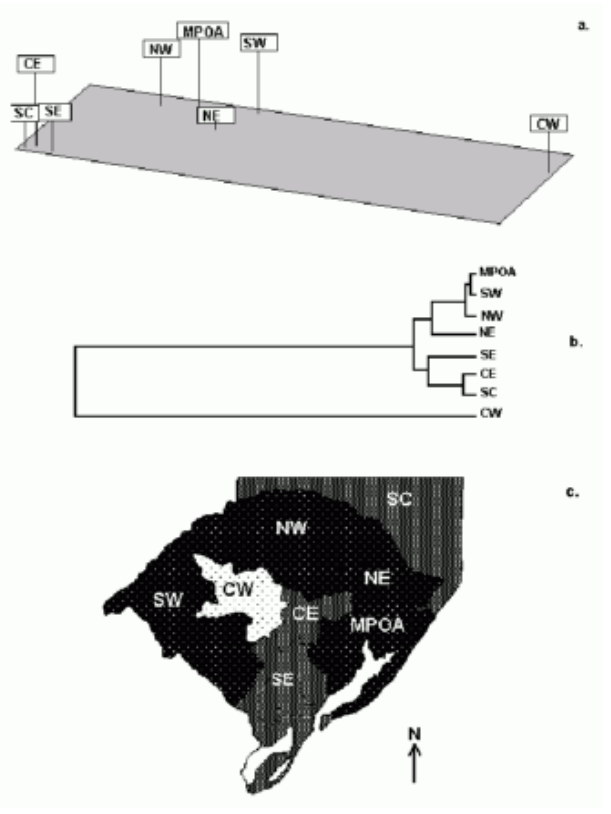
Figure 4 - Multivariate analyses of the interethnic admixture: (a) principal coordinates, (b) dendrogram obtained from the D both distributions. Shading is arbitrary, but indicates the major associations among mesoregions.